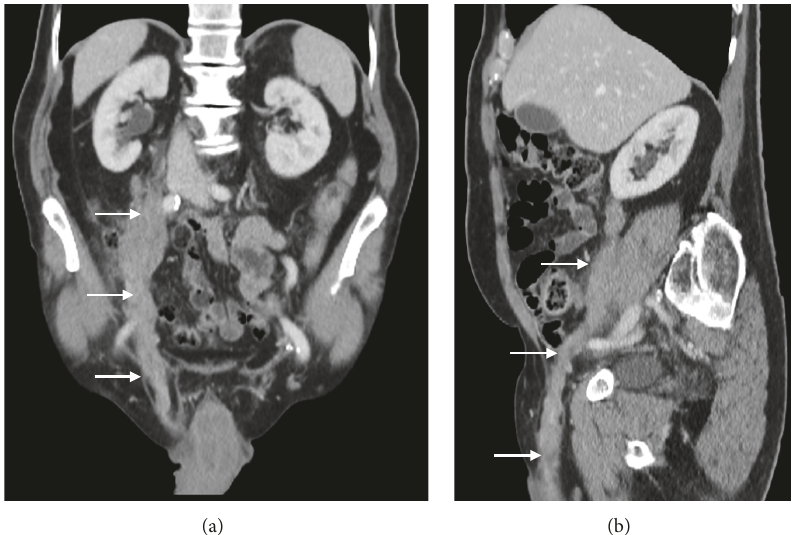
Figure 3: (a and b) Coronal and sagittal reformatted CT images of the abdomen and pelvis with contrast which demonstrate cord-like soft tissue extension from the right testicle into the retroperitoneum along the spermatic cord and gonadal vein.